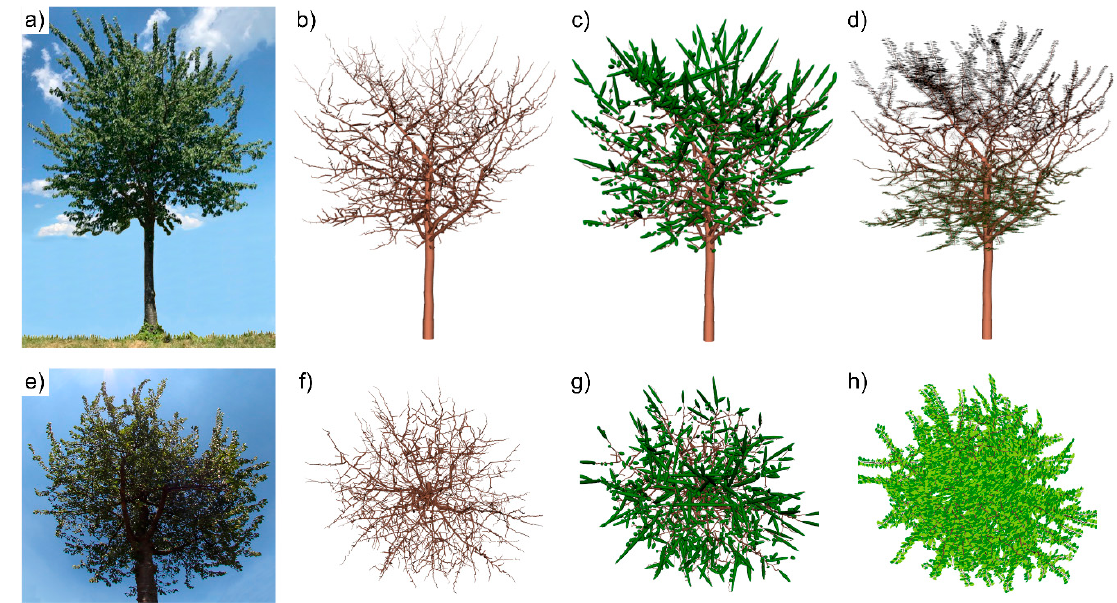
Figure 2. Upper images: ( a ) Photograph of wild cherry tree Pa_5 (DBH = 26.3 cm; height = 9.0 m); ( b ) QSM only, as the no leaves mode (NoL); ( c ) QSM and leaf-on mode with ellipsoidal leaves (EL); ( d ) QSM and leaf-on mode using realistic leaves (RL). Photograph as a worm’s eye view of the tree crown ( e ); bird’s eye view of the QSMs for NoL ( f ), EL ( g ), and RL ( h ).